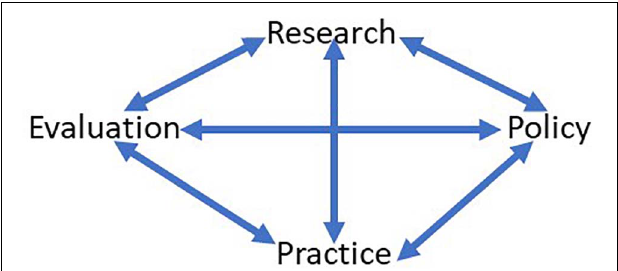
FIGURE 2 | Necessary connections among community-oriented climate adaptation research, policy development and implementation, results and consequences of putting policies into practice, and evaluation and adaptive learning from applications. Bidirectional areas indicate two/multi-way information